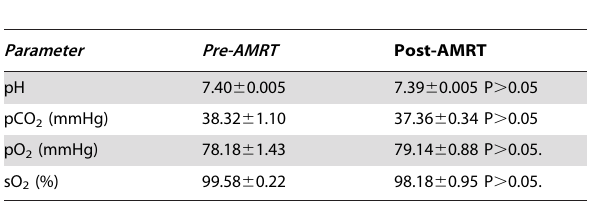
Table 1. Arterial blood gas analysis Pre- and